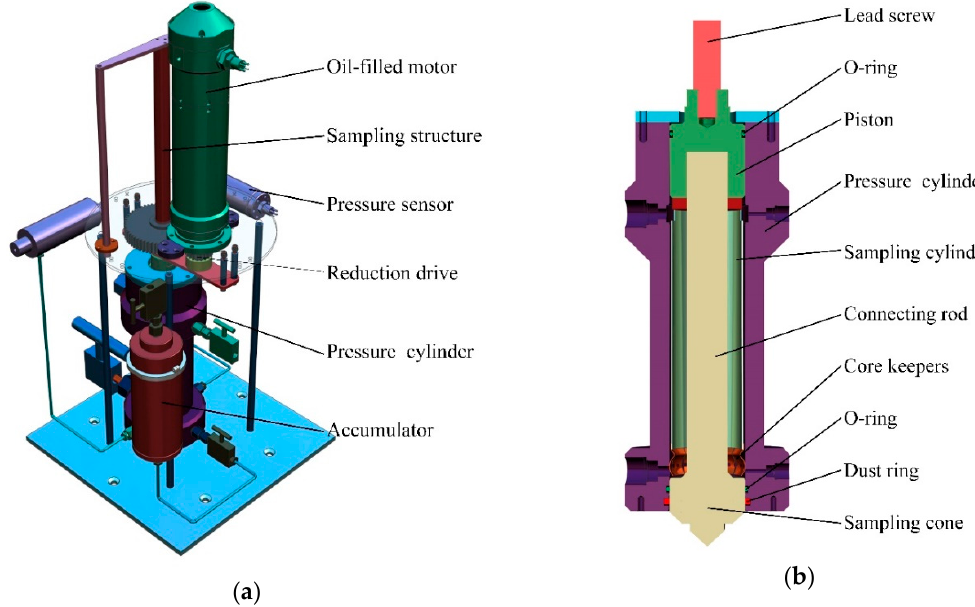
Figure 1. ( a ) The overall structure of the device; ( b ) The sampling structure part of the device.